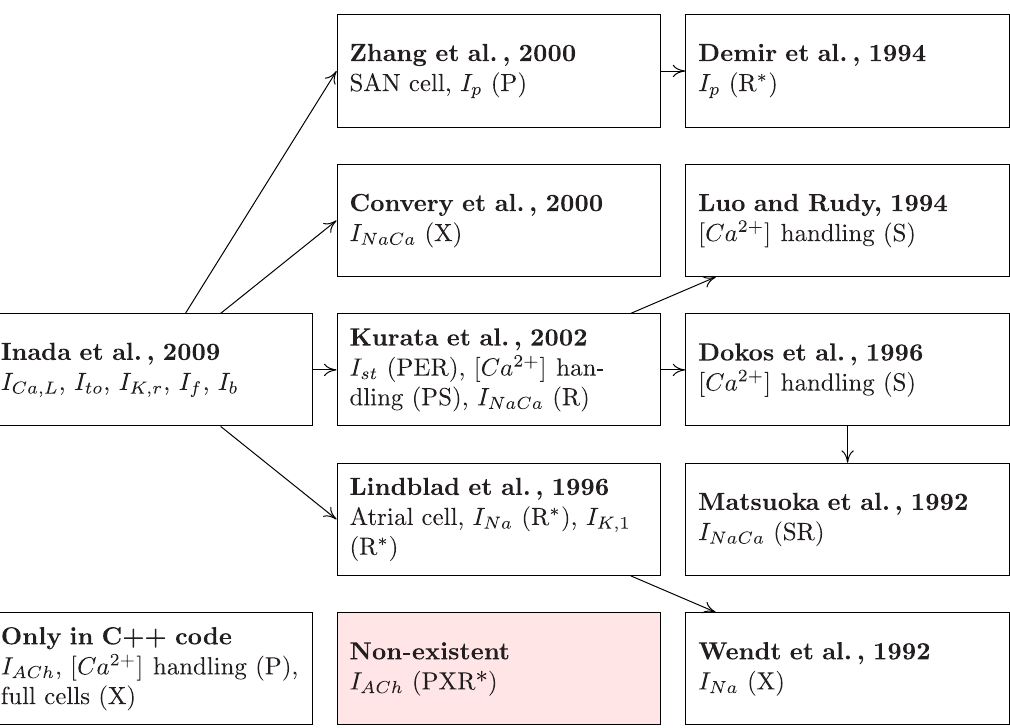
Fig 1. Tree of references that we traversed to obtain all relevant information to understand and test the model. Arrows between nodes indicate that the article at the beginning of the arrow cites the article at the end of the arrow. Each node contains a list of model parts that could only be reproduced by using this reference. This is further specified by distinguishing if the reference was needed to determine parameter values (P), correct errors (E), untangle equation semantics for modularization (S), obtain an additional (R) or the only available (R � ) reference plot, or to reproduce the experiment protocol (X).